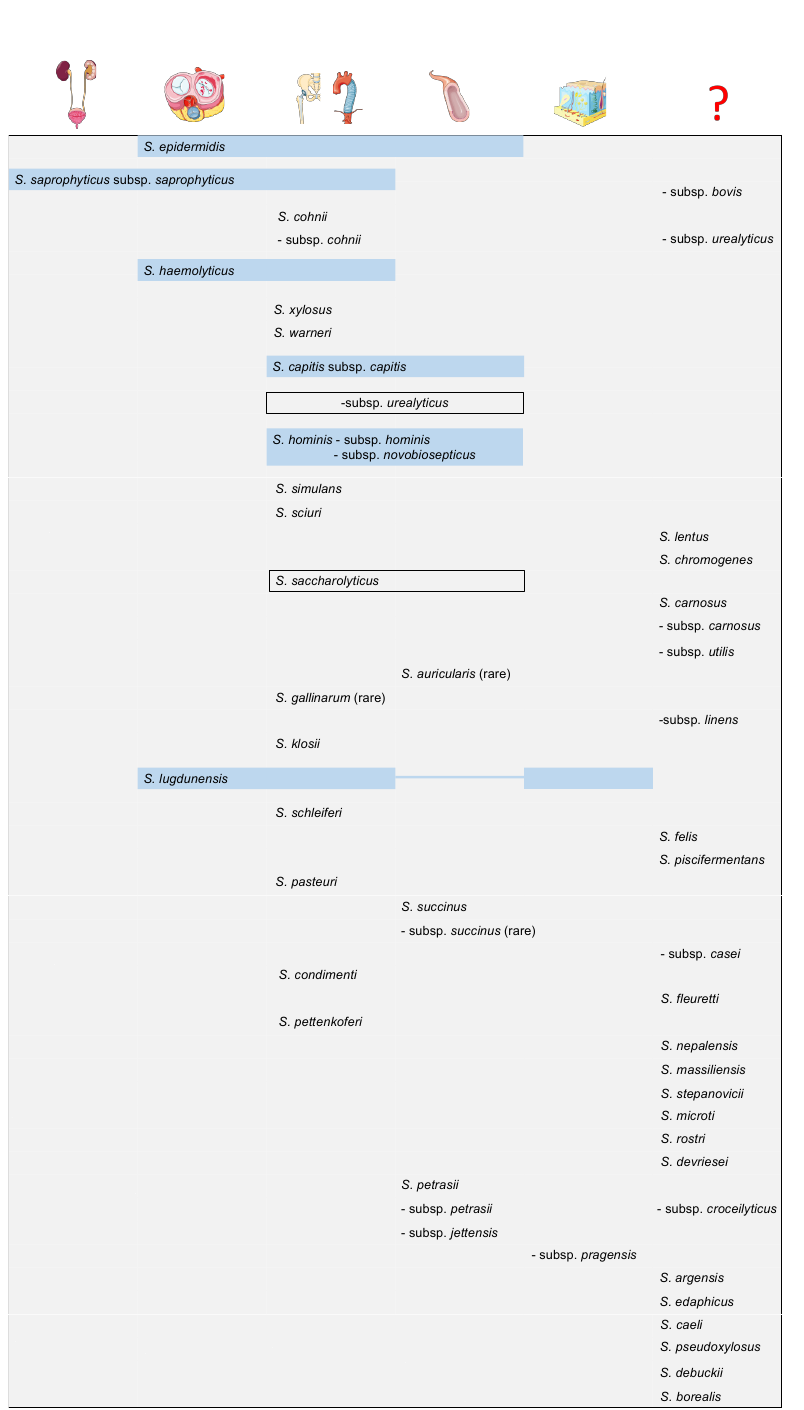
Figure 1. Overview of CoNS, according to the predominantly affected organ site or infectious syndrome, from left to right: urinary tract; cardiac valves; prosthetic joints and vascular grafts; bloodstream infections; skin and soft tissue infections; the question mark designates species of unknown clinical relevance. Most prevalent and relevant species are highlighted in blue; species are depicted in accordance with their first description, from top to bottom. Pictograms were taken with permission from Servier Medical Art [21].